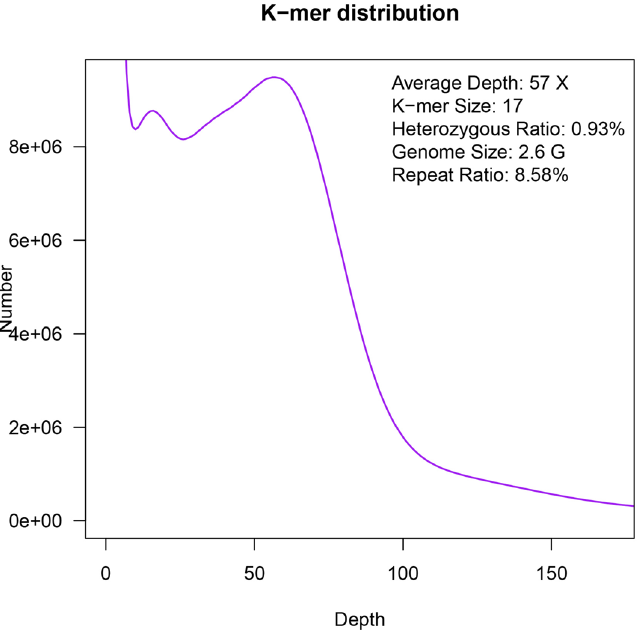
Figure 1. 17-mer distribution of sequencing reads. 17-mer sequences were extracted from filtered database of pair-end library.